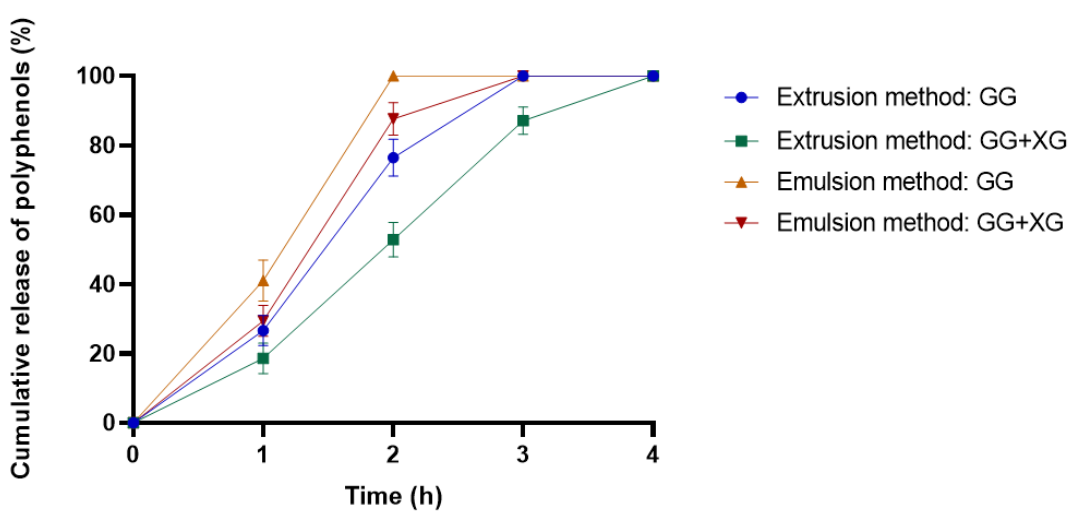
Figure 4. In vitro release assays of microspheres based on gellan and xanthan gum obtained by extrusion and emulsion method.